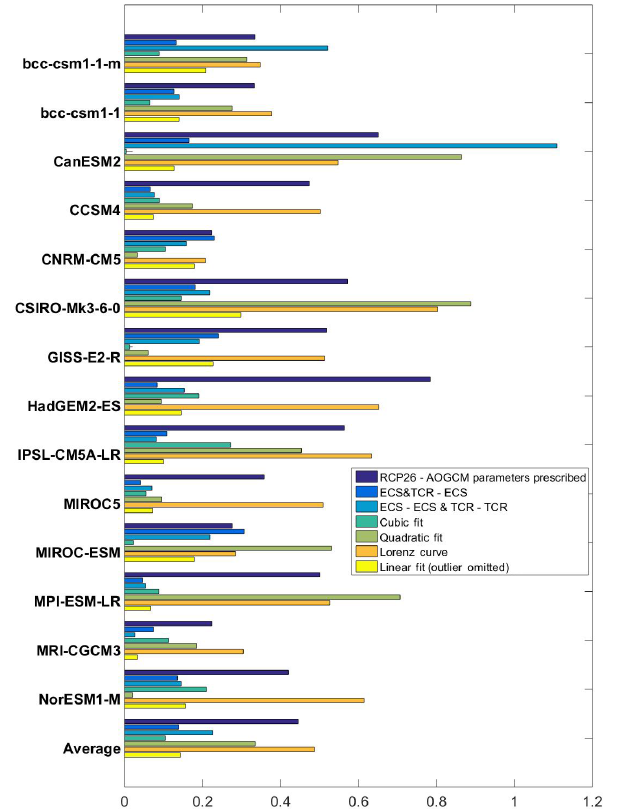
Figure 5. Modulus of mean temperature deviations (K) over the period 2071–2100 (MTD) for PH99 from AOGCMs when α , µ , ECS, and TCR from Table 2 are related to ECS and TCR in Table 1. Using linear (yellow bars), quadratic (light green bars), and cubic functions (dark green bars), α and µ are related to ECS when the outlier is put out for the linear case. Using linear fits, ECS and TCR are related to ECS (blue bars). Using linear fits, ECS and TCR are related to ECS and TCR, respectively (light blue bars). The dark blue bars show the deviations for RCP2.6 when α and µ are from Table 1 and not fitted (the same as Fig. 2). The orange bars indicate MTD using Lorenz’s